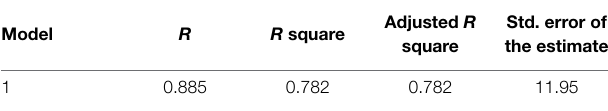
TABLE 4 | Model summary for teachers’ ambiguity tolerance, enthusiasm, and burnout. Model